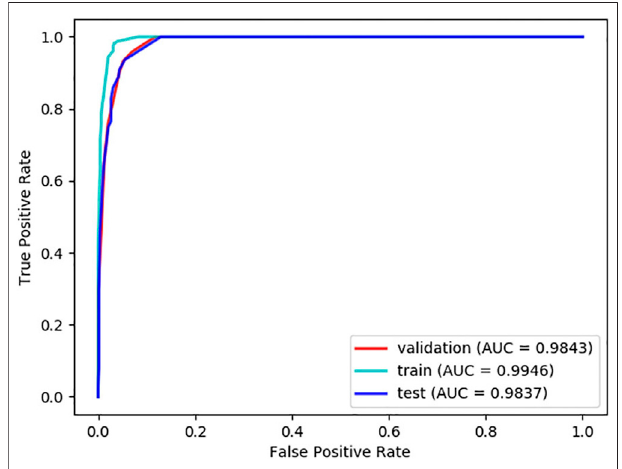
FIGURE 5 | ROC curves of independent testing.